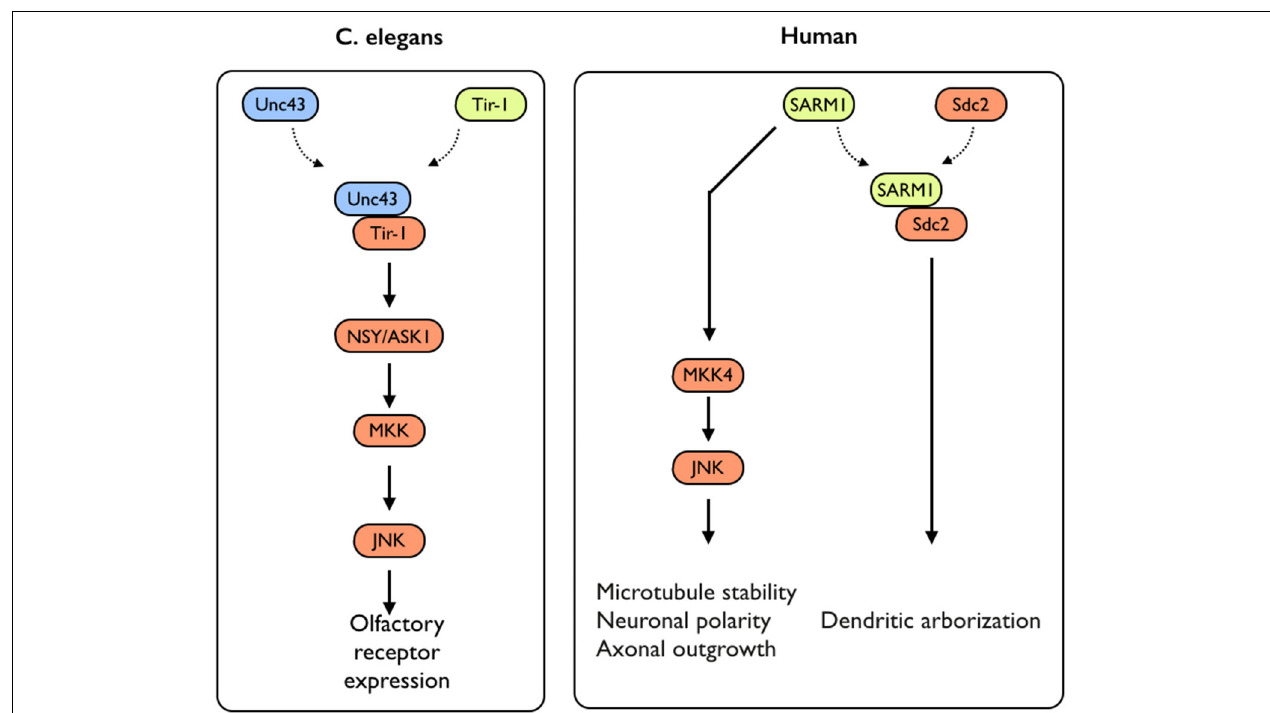
FIGURE 3 | SARM1-mediated signaling in C. elegans and humans. In C. elegans , Sarm1/Tir-1 has been shown to regulate left–right asymmetric expression of odorant receptor genes in olfactory neurons via association with Unc43 (homolog to the mammalian CamKII), which leads to downstream activation of the NSY/MKK/JNK signaling pathway. In mammals, Sarm1 was shown to play multiple roles in controlling